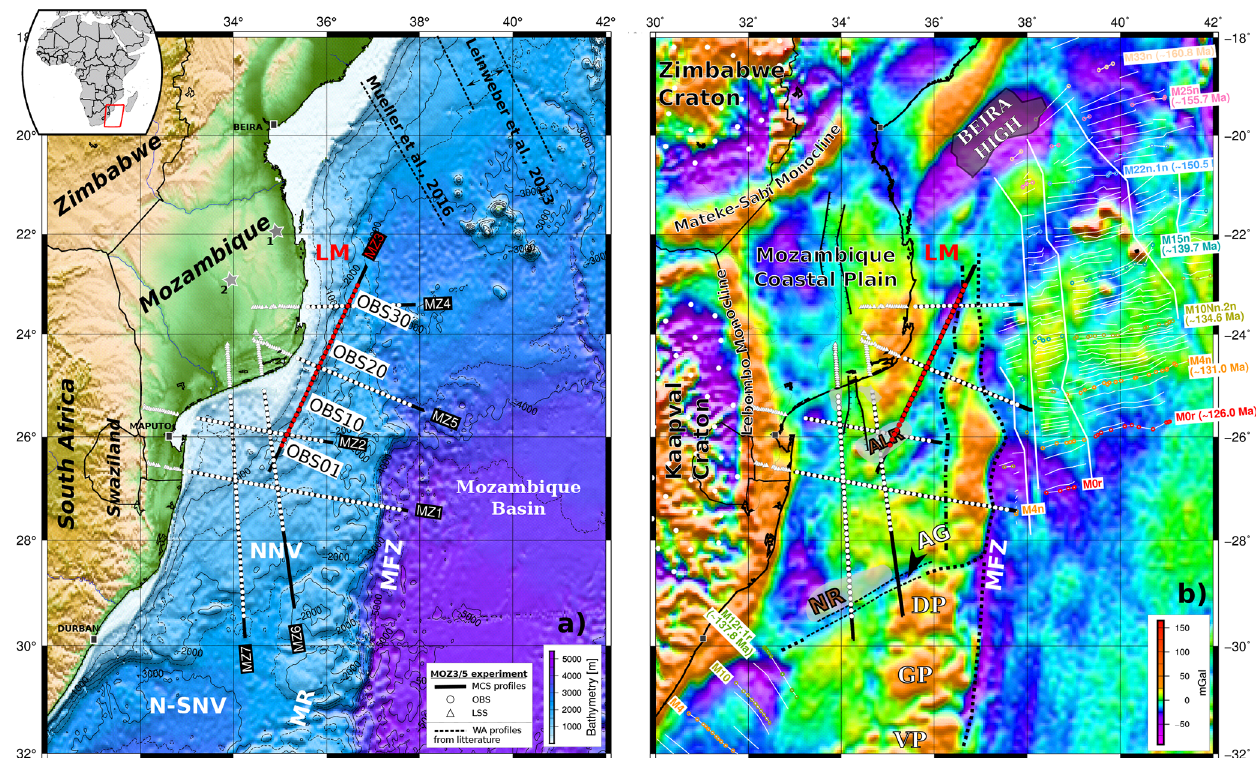
Figure 2. Maps of the PAMELA MOZ35 seismic experiment. Combined MCS and wide-angle profiles are shown as black lines. MZ3 is highlighted, with red dots marking positions of OBS. Instruments (OBS and land stations) and names of other profiles are in white. (a) Topography and bathymetric data (Smith and Sandwell, 1997) with inset for location of studied area. The gray stars indicate the location points of 1D Vs depth profiles from Domingues et al. (2016). LM is the Limpopo margin, shown in red; NNV is the North Natal Valley; N- SNV is the northern South Natal Valley; and MR is the Mozambique Ridge. (b) Free-air gravity anomaly grid (Pavlis et al., 2012; Sandwell et al., 2014). Main features known in the area are from Mueller and Jokat (2019), which are based on Leinweber and Jokat (2012) and Mueller and Jokat (2017) for the magnetic spreading anomalies in the Mozambique Basin, and on Goodlad et al. (1982) for the magnetic anomalies in the South Natal Valley. The outline of the Naude Ridge (NR) is from Goodlad (1986). ALR is the Almirante Leite Ridge, AG is the Ariel Graben, DP is the Dana Plateau, GP is the Galathea Plateau, and VP is the Vauban Plateau.